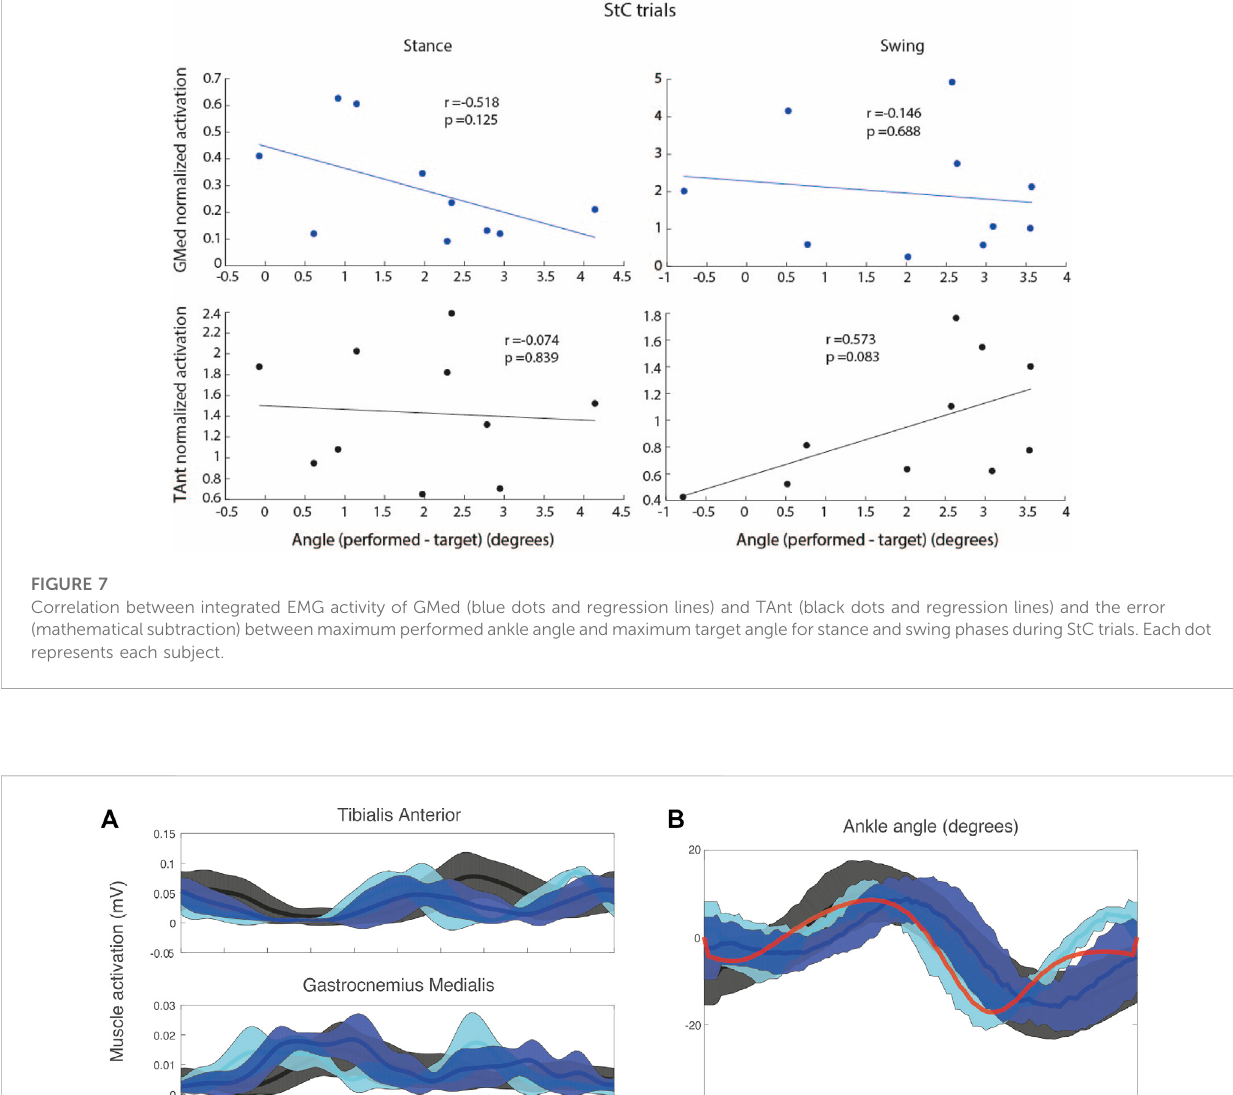
treadmill baseline vs. SwC OFF 1; e p = 0.00 for treadmill baseline vs. SwC OFF 2; e p = 0.03 for SwC ON vs. treadmill POST SwC; e p = 0.01 for SwC OFF 1 vs. treadmill POST SwC; and e p = 0.00 for SwC OFF 2 vs. treadmill POST SwC). GMed EMG activity was signi fi cantly reduced in SwC training trials compared to treadmill trials during stance phase. For all conditions, GMed EMG activity was similar when comparing baseline and treadmill POST SwC trials.